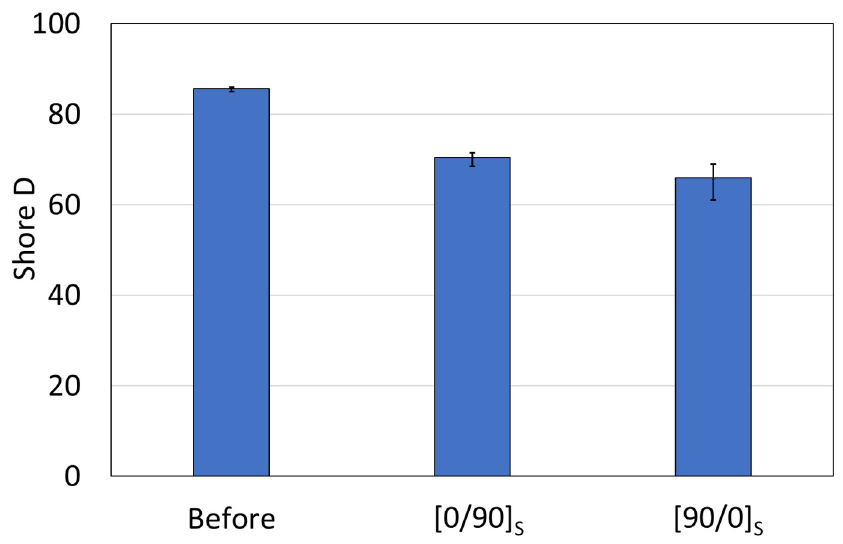
Figure 9. Shore D hardness of the specimen before and after the test.